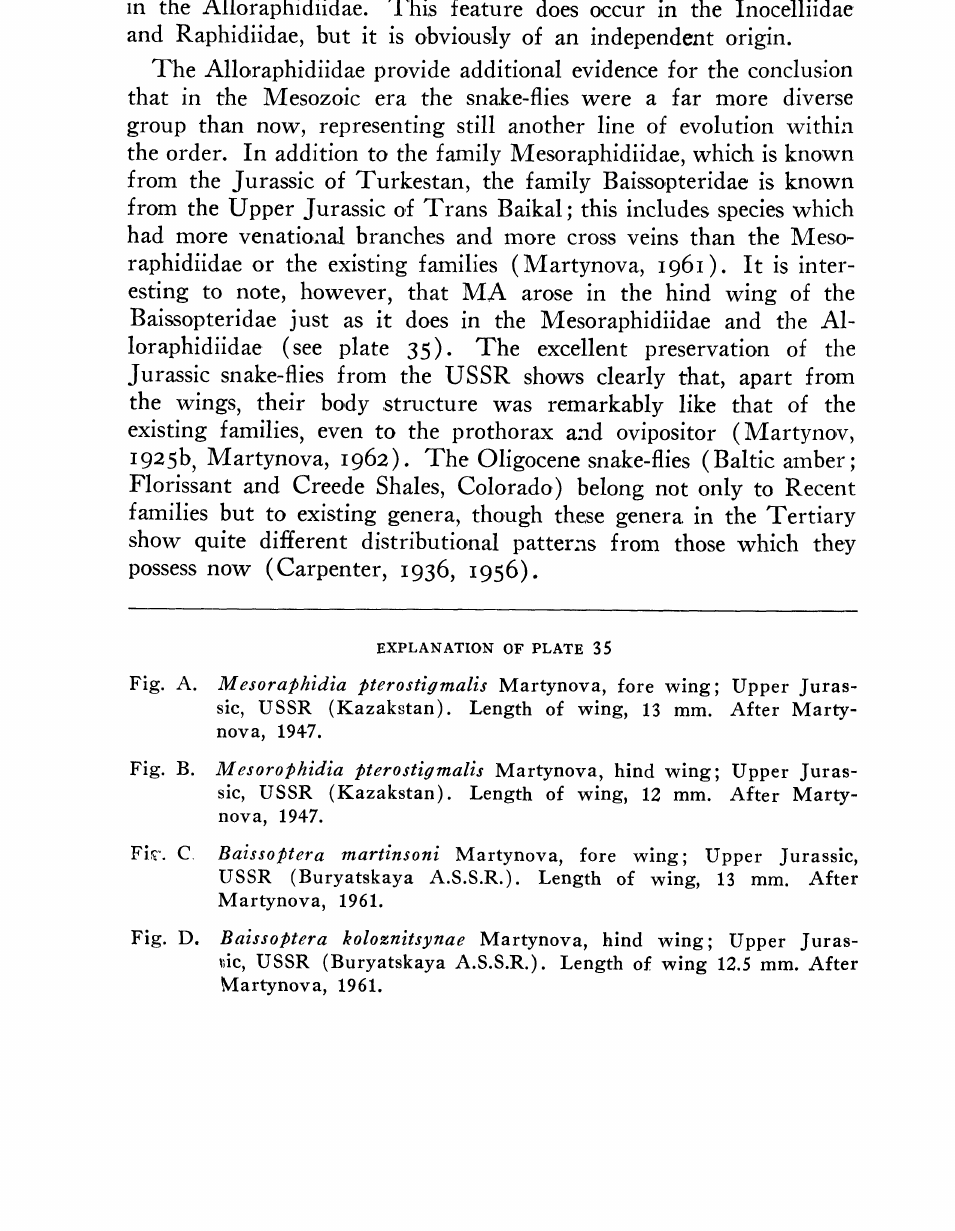
Fig. D. Baissoptera koloznitsynae Martynova, hind wing; Upper Juras- ic, USSR (Buryatskaya A.S.S.R.). Length of wing 12.5 mm. After Martynova,